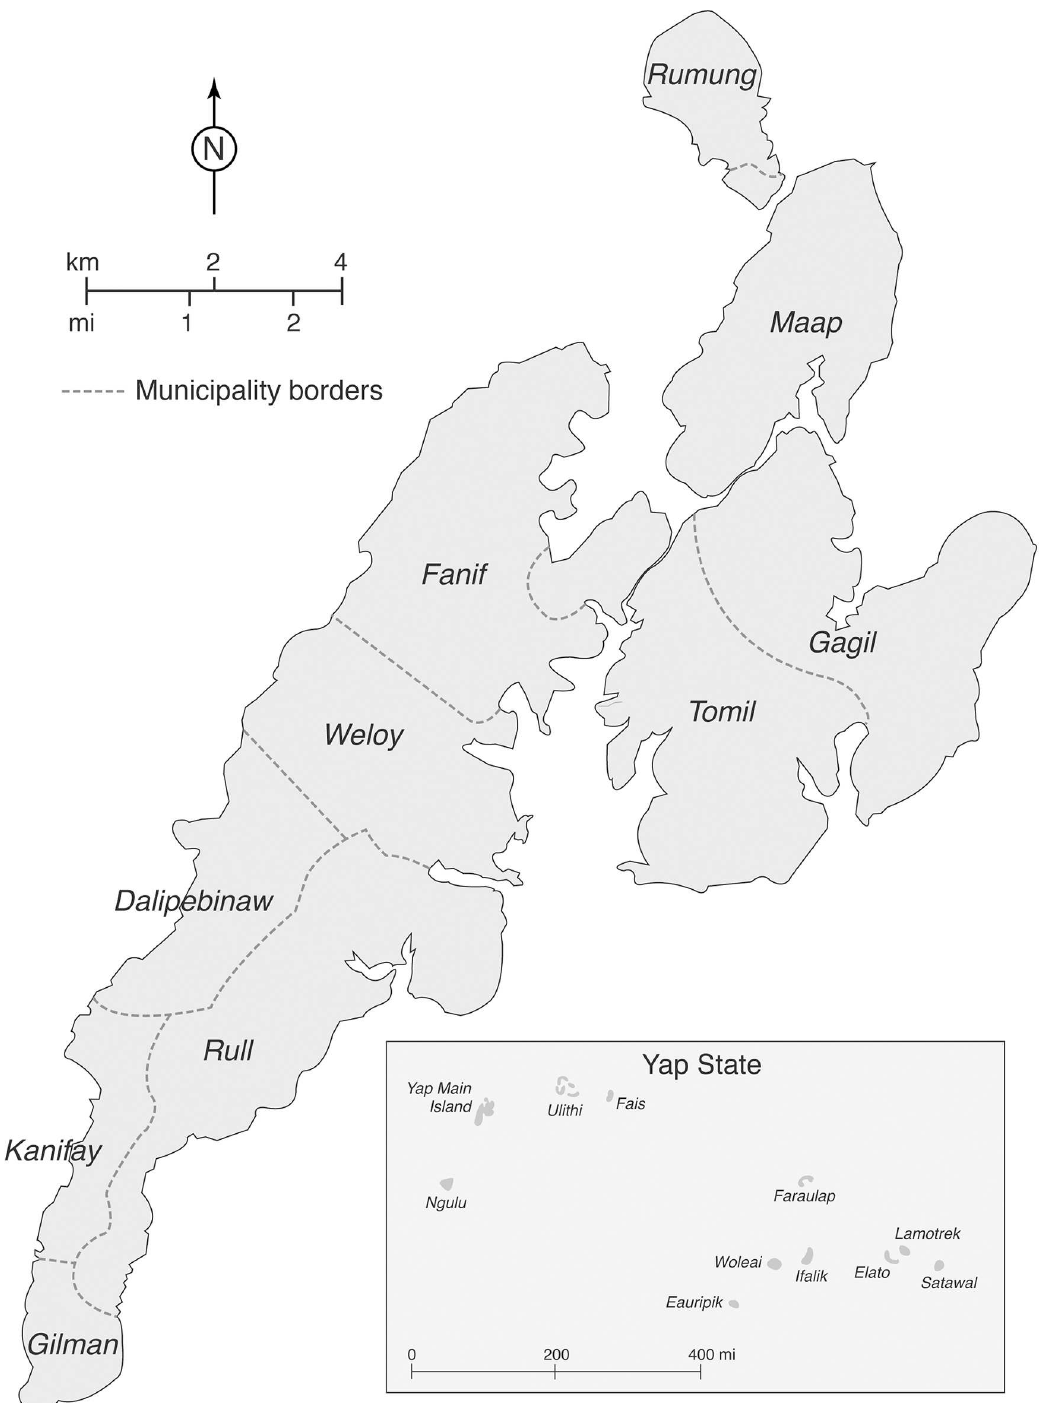
Fig 1. Yap Main Island and Yap State, Federated States of Micronesia.